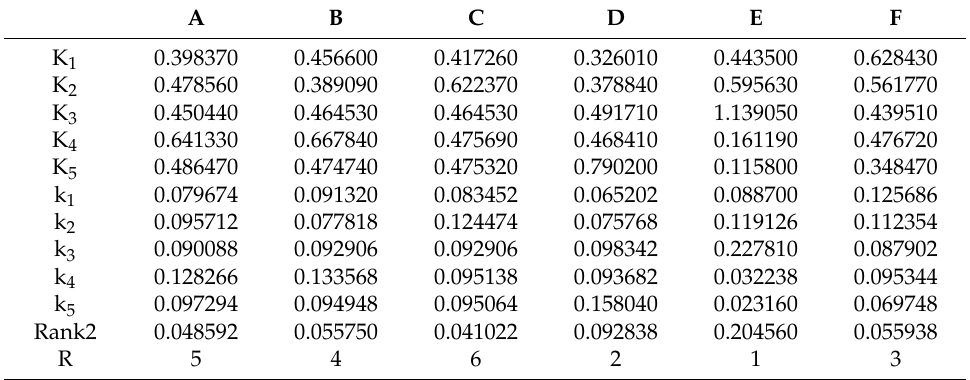
Table 5. Extreme difference analysis for the void volume fraction in the groove of the clinched joint.